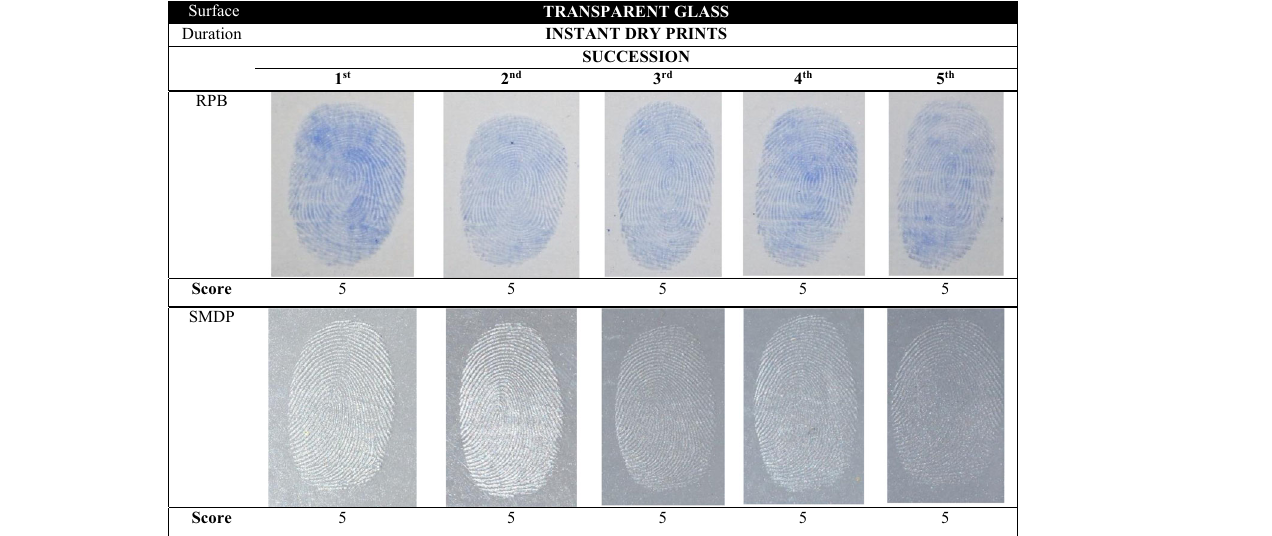
Table 9 Development of successive prints on transparent glass surface using Robin powder blue and silver magnetic dual powder Surface TRANSPARENT GLASS